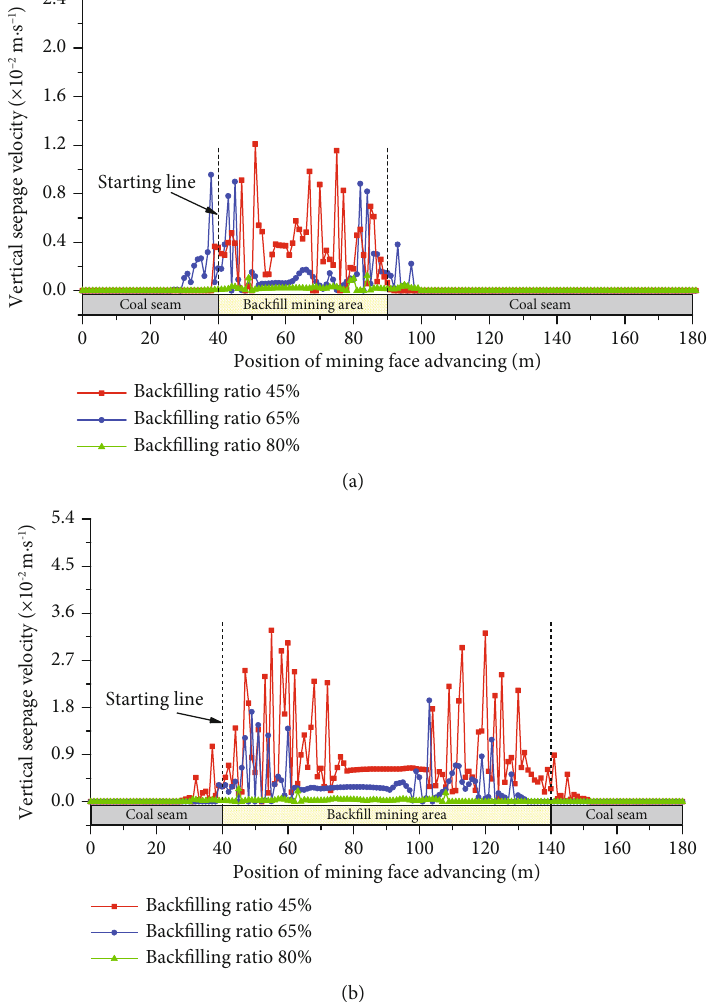
Figure 7: Vertical seepage fl ow distribution of KAS with various back fi lling ratios: (a) advancing distance 50m; (b) advancing distance